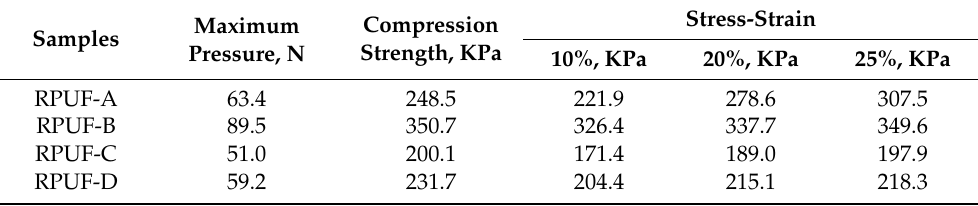
Figure 7. Stress-strain curves of the prepared RPUFs for the determination of the compressive strength. Table 5. Mechanical properties of RPUFs.